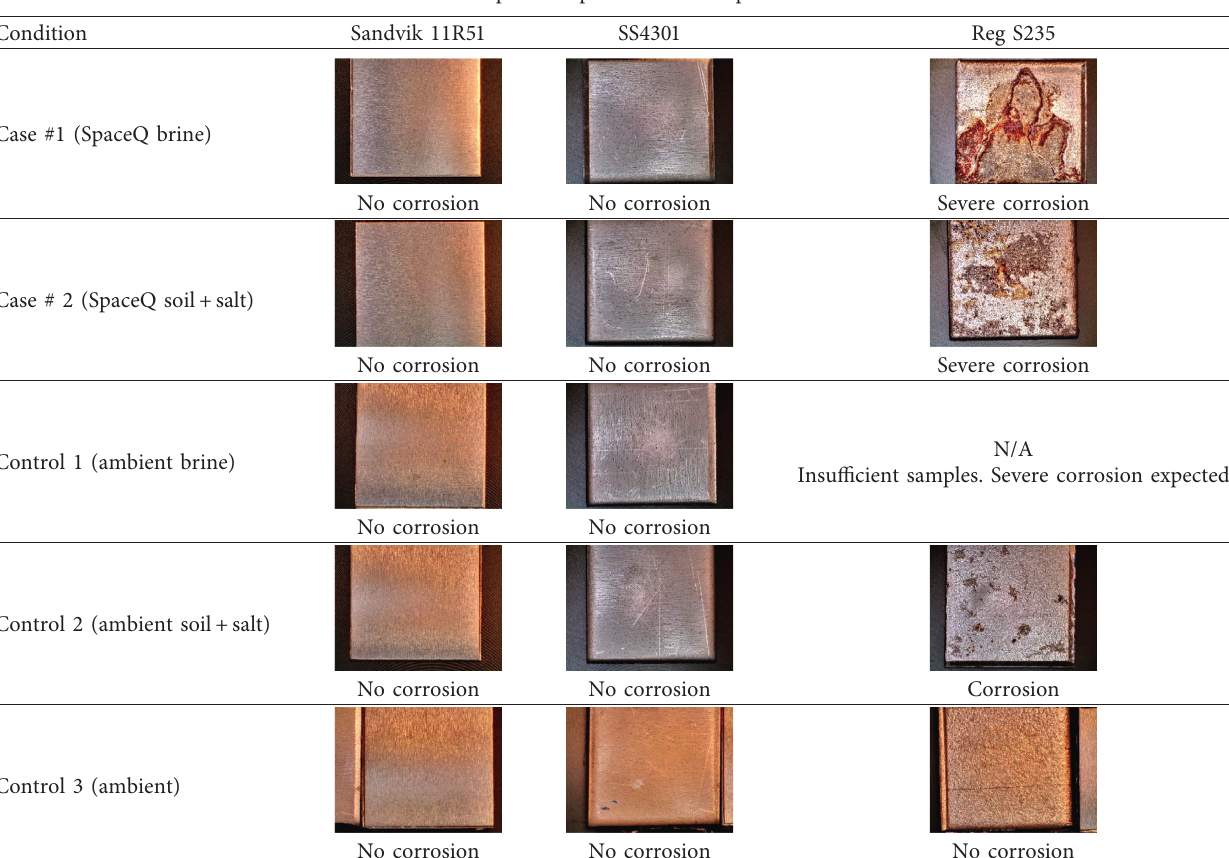
Table 2: Optical inspection of the experiments.